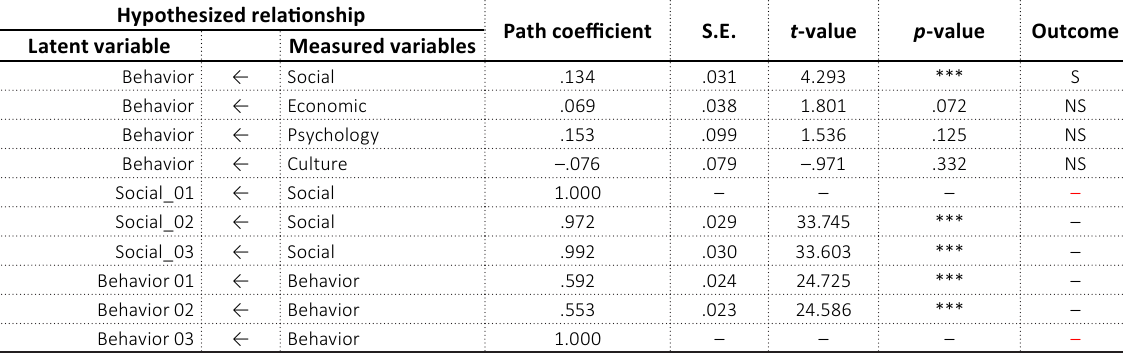
Table 4. Model parameter maximum likelihood estimates Hypothesized